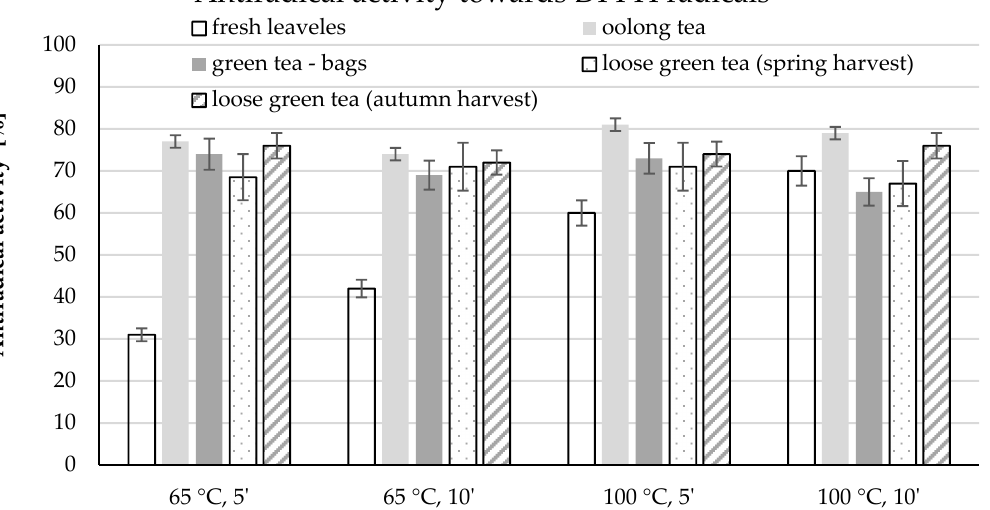
Figure 6. Antiradical activity towards DPPH radicals in water infusions of tea shrub leaves and various types of teas depending on the brewing parameters.